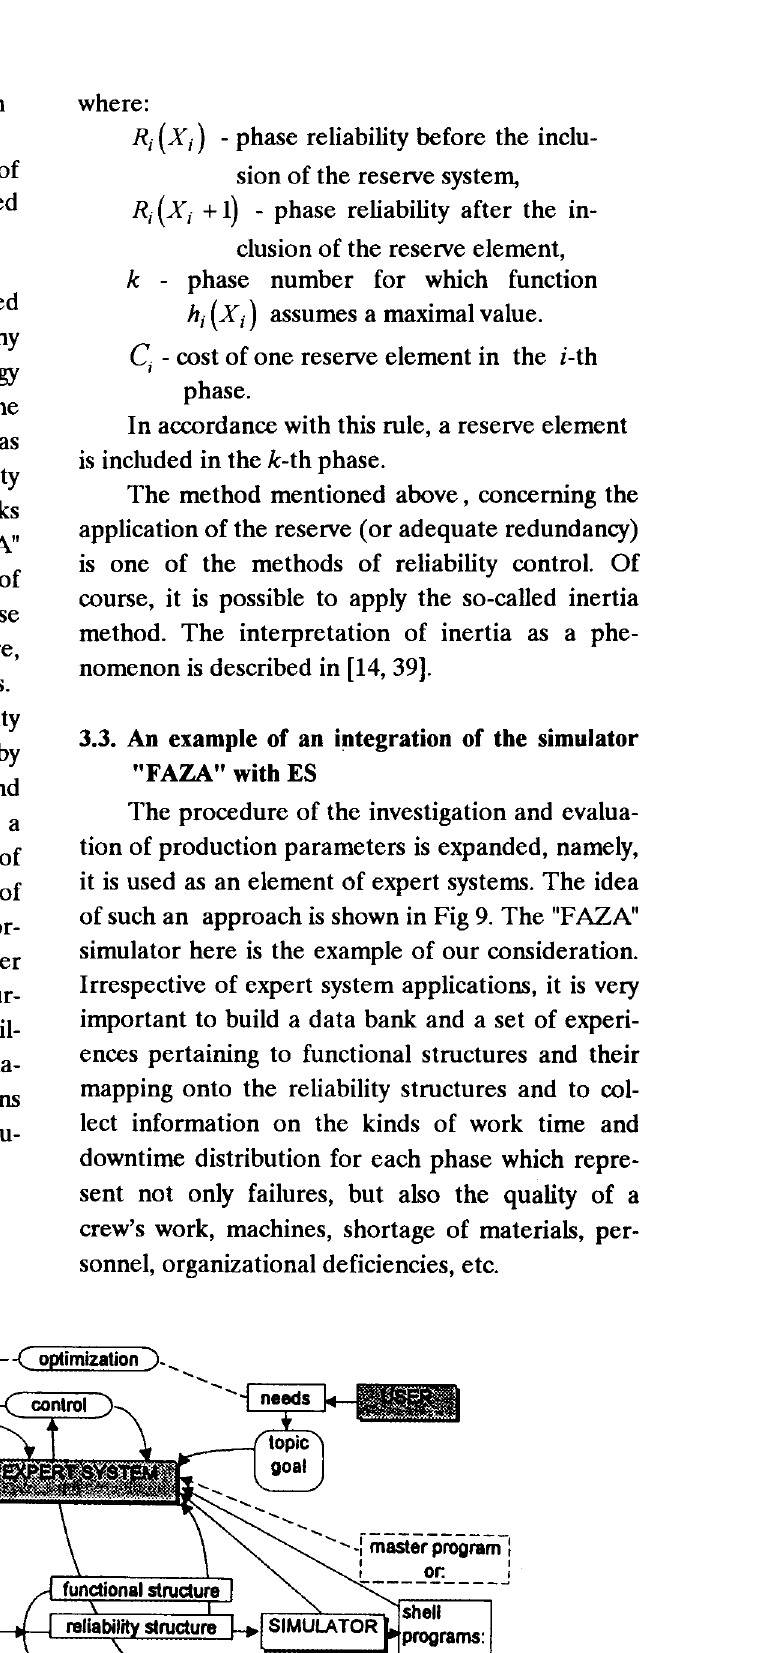
Fig 9. Example of simulation in